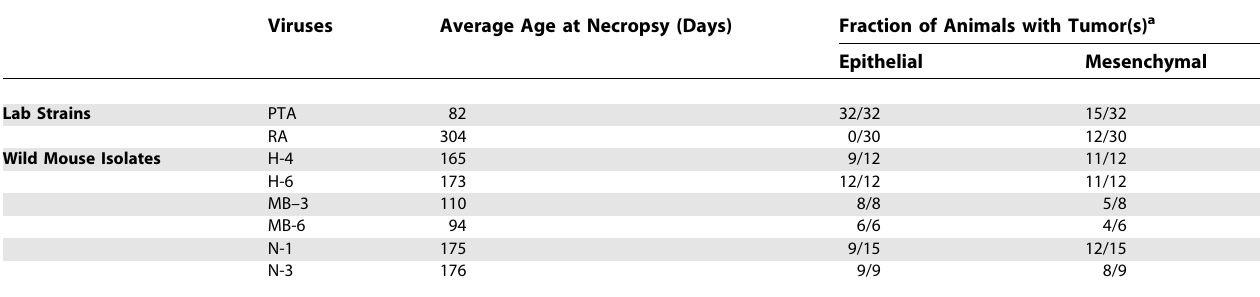
Table 3. Tumor Induction by Laboratory Strains and Feral Mouse Isolates of Polyomavirus Viruses Average Age at Necropsy